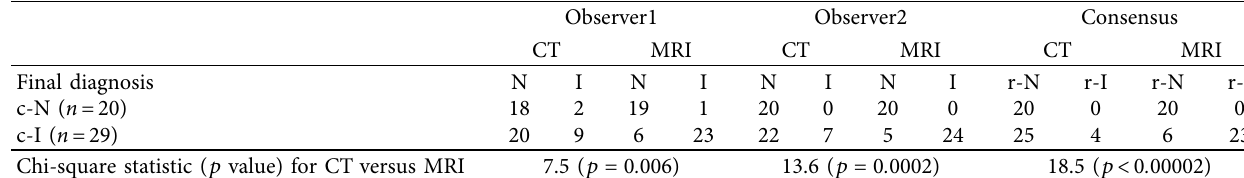
Table 3: Potentially neoplastic (N) and infective/inflammatory (I) diagnoses on CT and MRI for Observer1, Observer2, and consensus compared to final clinical diagnoses.